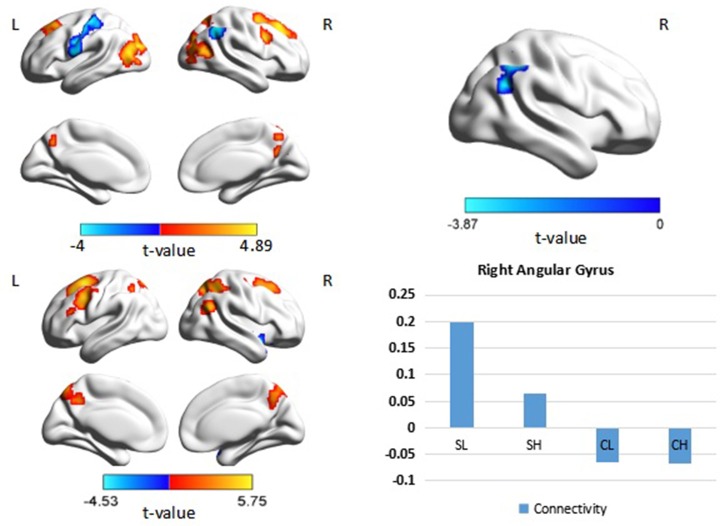
Psychophysiological interaction effect using the right DLPFC as a seed region in each group and between group effects (p < 0.05, corrected, cluster size = 69). Color bars indicate the t-statistic. The right bottom panel indicates the activation pattern of each subgroup. SL, low-performance schizophrenia group; SH, high-performance schizophrenia group; CL, low-performance control group; CH, high-performance control group.